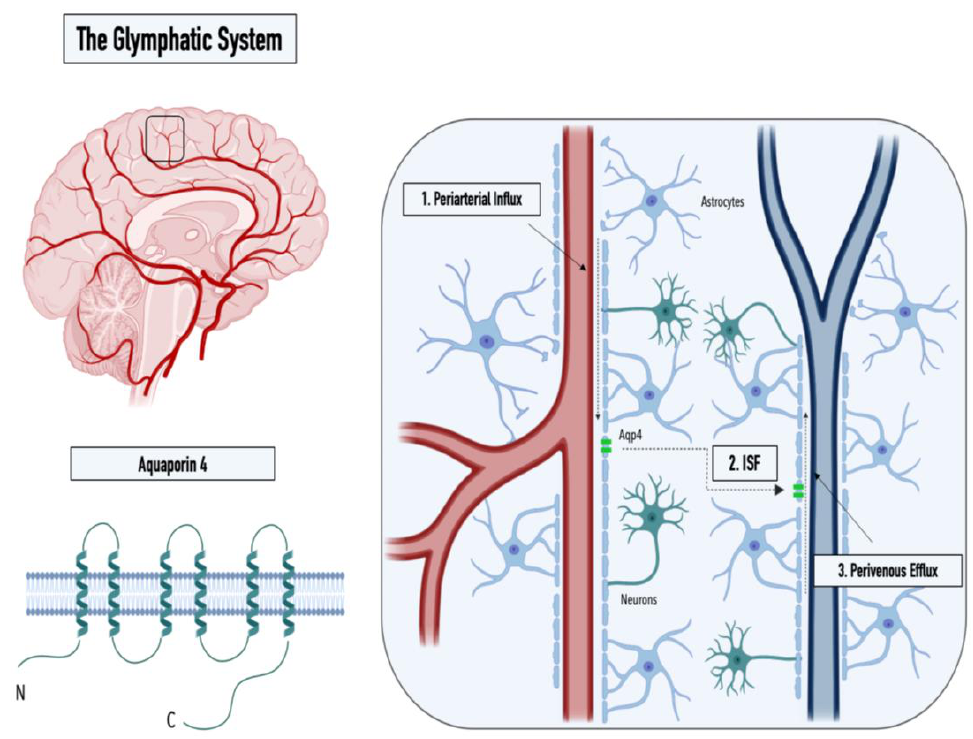
Figure 1. Graphical illustration of the structure of the water channel aquaporin-4 (left panel) and the three steps of the glymphatic pathway: ( 1 ) CSF influx into the Virchow–Robin spaces along arterioles, ( 2 ) influx of CSF into the parenchyma, and ( 3 ) perivenous efflux of the CSF/ISF mixture (right panel).